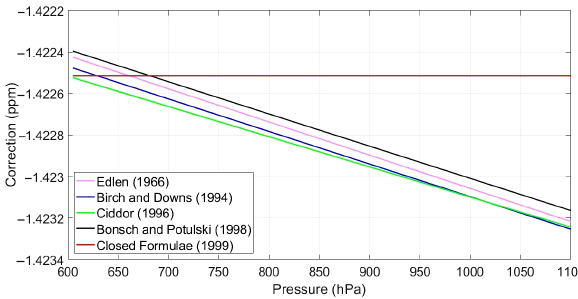
Figure 11. EDM corrections in every interval of 5